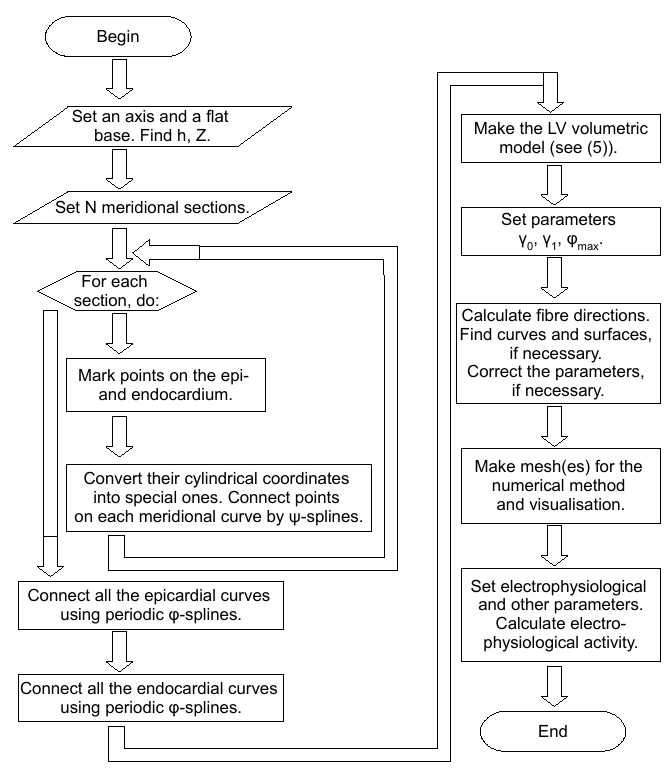
Figure 15. Flowchart displaying the steps for the construction and use of the spline-based LV